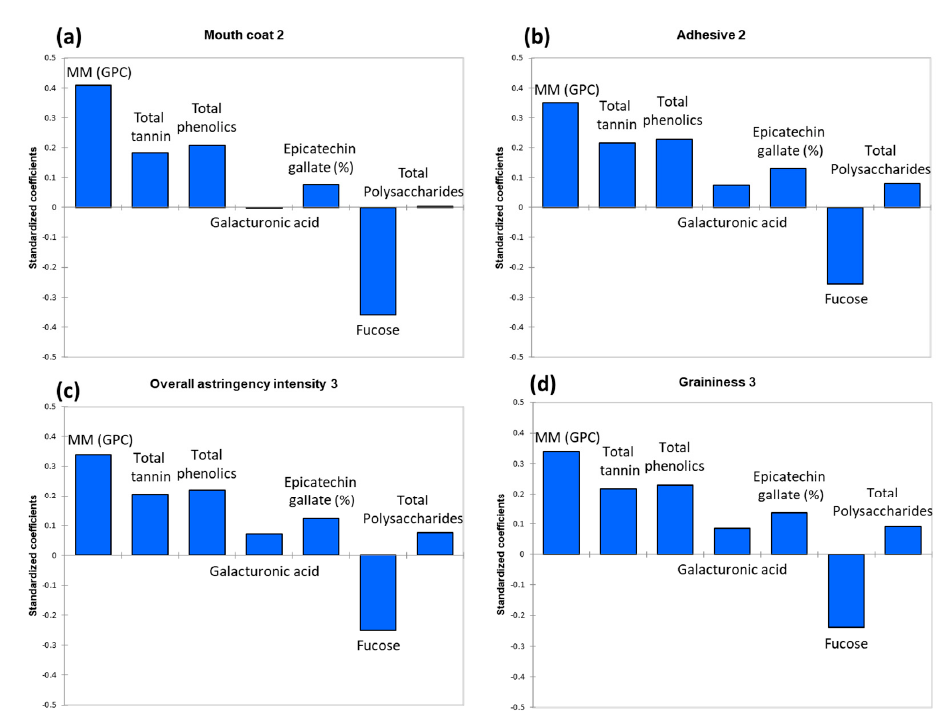
Figure 7. Standardised coefficients of the partial least squares regressions between the significantly different sensory attributes in PP (Y) and the selected (based on the variable importance in the projection) significantly different chemical parameters (X). MM (GPC) is tannin molecular mass determined by gel permeation chromatography at 50% elution. ( a ) Mouth coat 2 (20–30 s after the expectoration of wine sample) ( b ) Adhesive 2 ( c ) Overall astringency intensity 3 (50–60 s after expectorating wine) ( d ) Graininess 3.